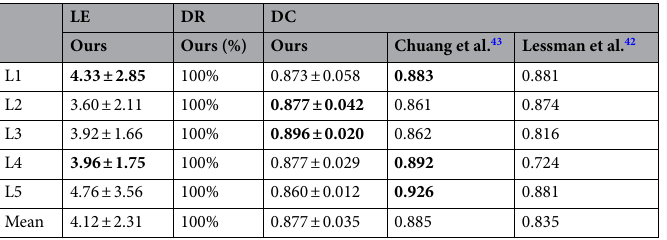
Table 9. Evaluation on xVertSeg dataset in terms of location error (LE), detection rate (DR) and dice coefficient (DC). Bold values indicates maximum and minimum values of the corresponding column or row.